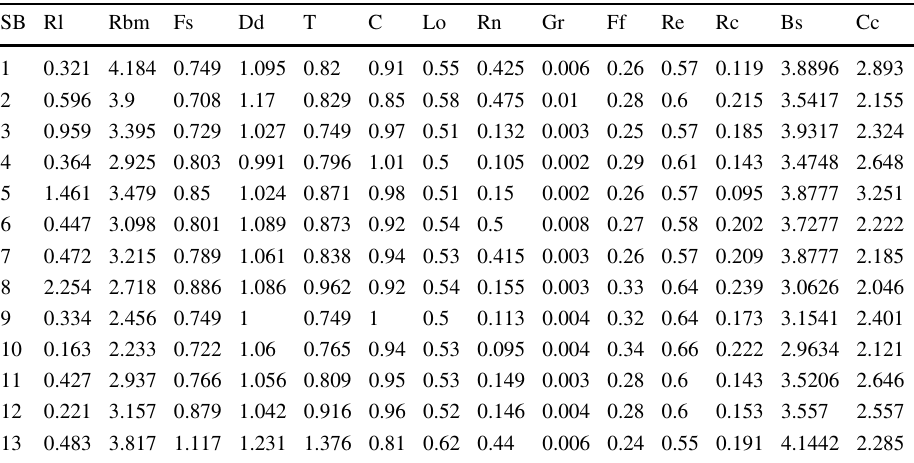
Table 4 Morphometric parameters of 13 sub-basins in Kansai–Kumari inter-fluvial site